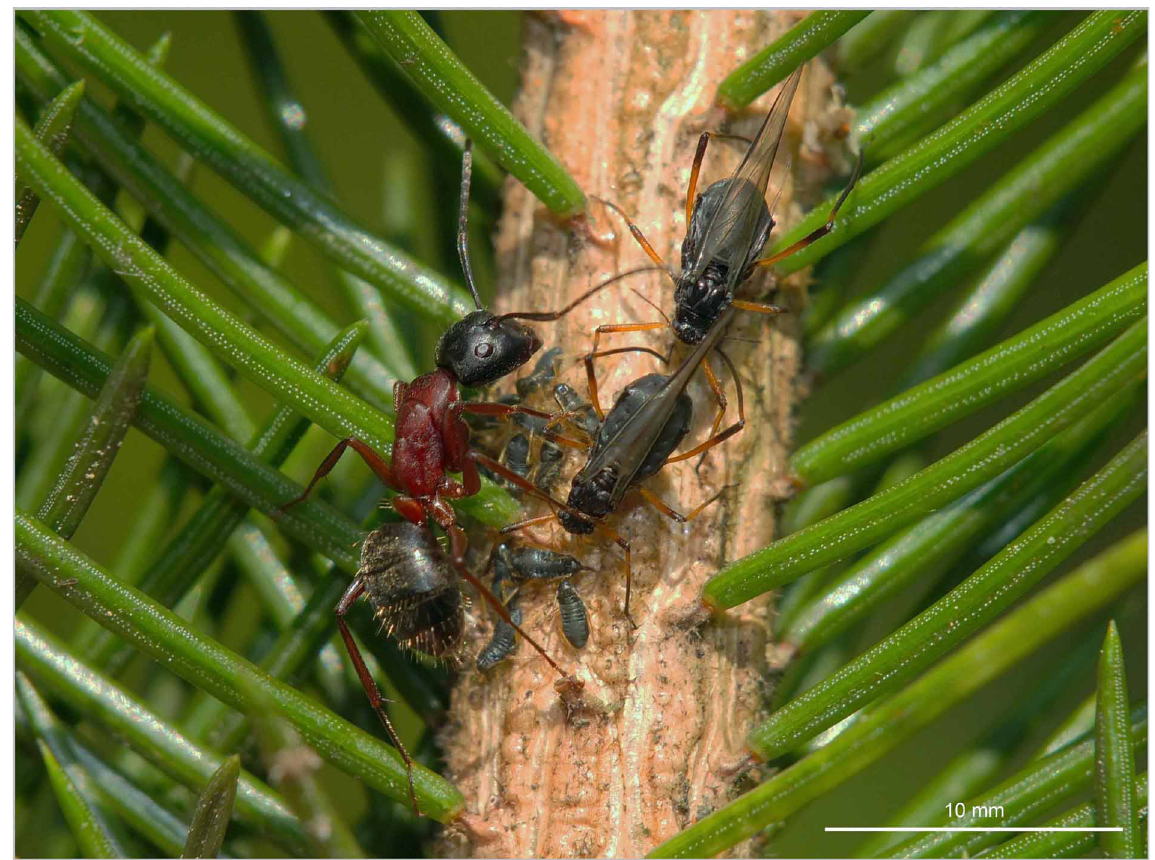
Fig. 29. Cinara (Cinara) piceae (Panzer, 1801) on Picea abies . Alatae with young nymphs, attended by Camponotus herculeanus (Linnaeus,